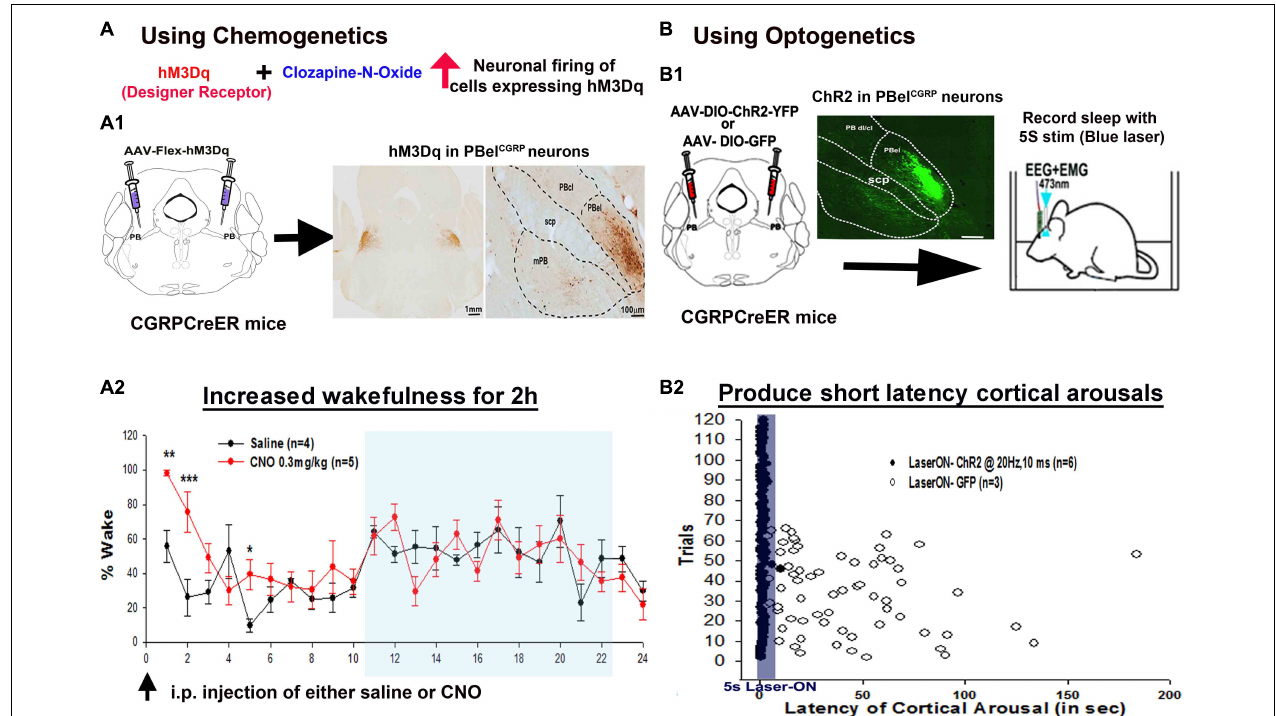
FIGURE 3 | Selective activation of the PBel CGRP neurons, using chemogenetics (A) and optogenetics (B) : The ( A1,B1) represent the strategy used to first express either hM3Dq or Channel rhodopsin (ChR2) in the PBel CGRP neurons, using the CGRP-CreER mice. Chemogenetic activation of PBel CGRP neurons, significantly increased wakefulness for 2 h post injection of the designer ligand (CNO) that binds hM3Dq (A2) . Optogenetically driving the PBel CGRP neurons also produced very short latency arousals both at 10 and 20 Hz, trials shown in the figure are from stimulation at 20 Hz (B2) . ( ∗∗∗ p < 0.0001; ∗∗ p < 0.001; 1-way or repeated measures ANOVA followed by Holm-Sidak for multiple comparison). [Adapted and modified from Kaur et al. (2017)]. Kaur et al. (2017) is published in a Cell Press journal “Neuron,” and no permissions needed to reproduce the modified versions of the published